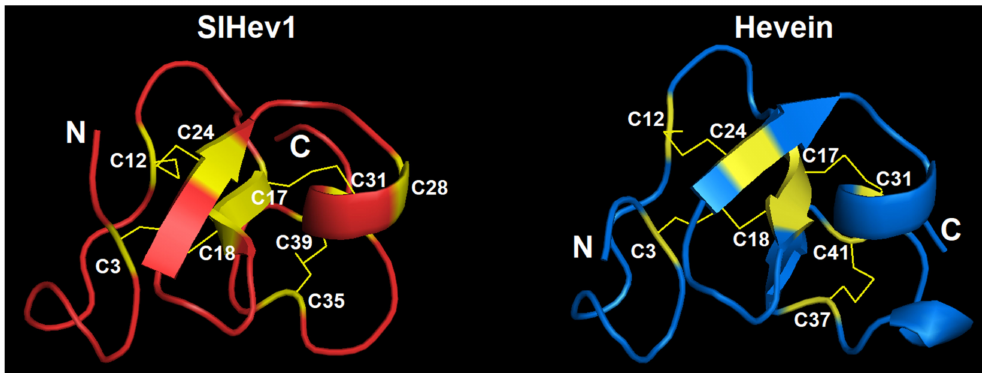
Figure 9. The 3D structure model of SlHev1 and the NMR solution structure of hevein (1HEV). Modeling was carried out using SWISS-MODEL [35]. Disulfide bonds are shown by thin yellow lines. The N-and C-termini are indicated by N and C, respectively. Cysteine residues are colored yellow and numerated according to their position in the polypeptide chain.